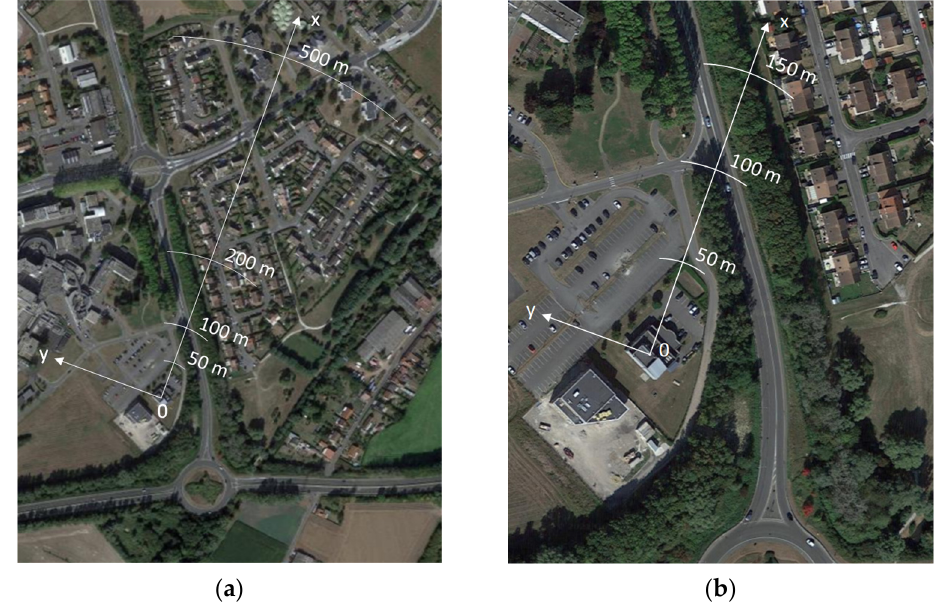
Figure 1. Near-field range ( a ) <500 m and ( b ) <150 m of the Beuvry hospital cyclotron (France) and distances from the discharge point with wind from 200°; the geographic coordinates of the origin shown on the images is (50.51404° N, 2.67255° E); screenshot Google Earth version 9.136.0.2 of 21 May 2021.